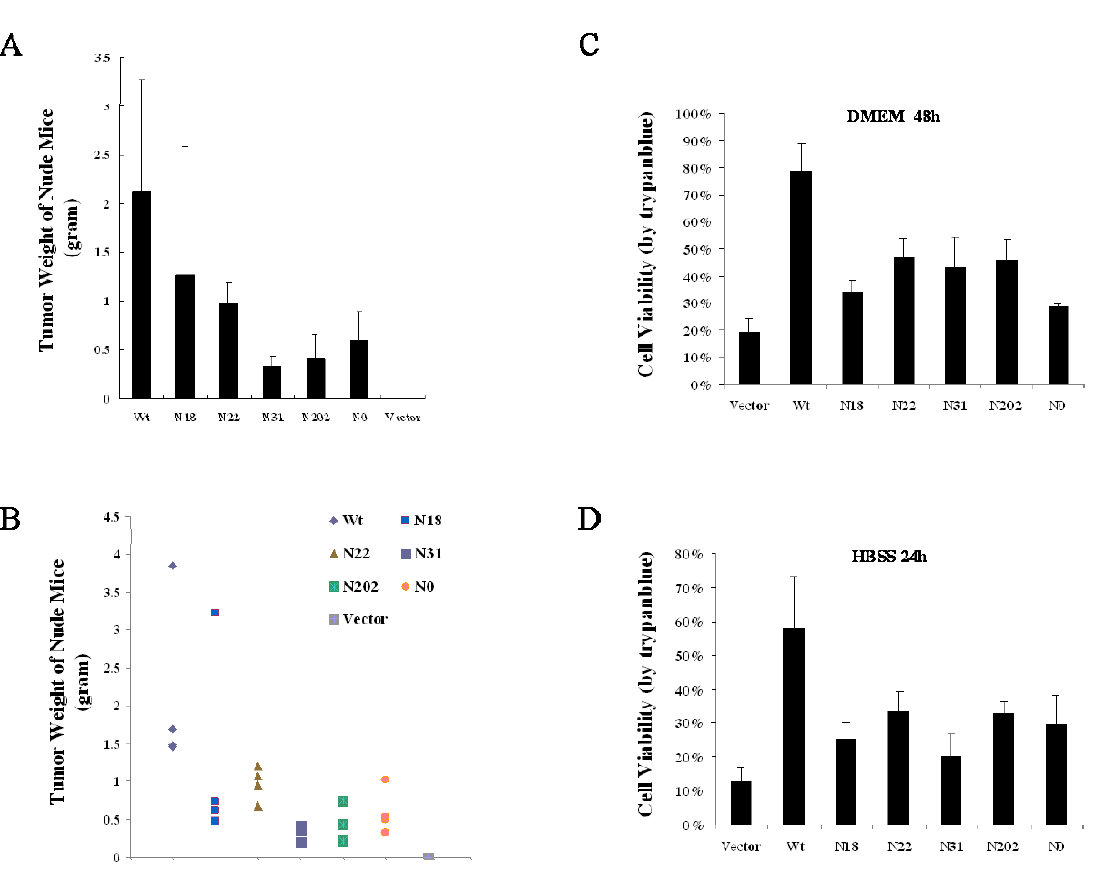
Figure 5. Glycosylation of vGPCR plays a key role in its tumorigenicity. ( A ) and ( B ): Glycosylation is crucial for vGPCR-dependent tumor formation in nude mice.